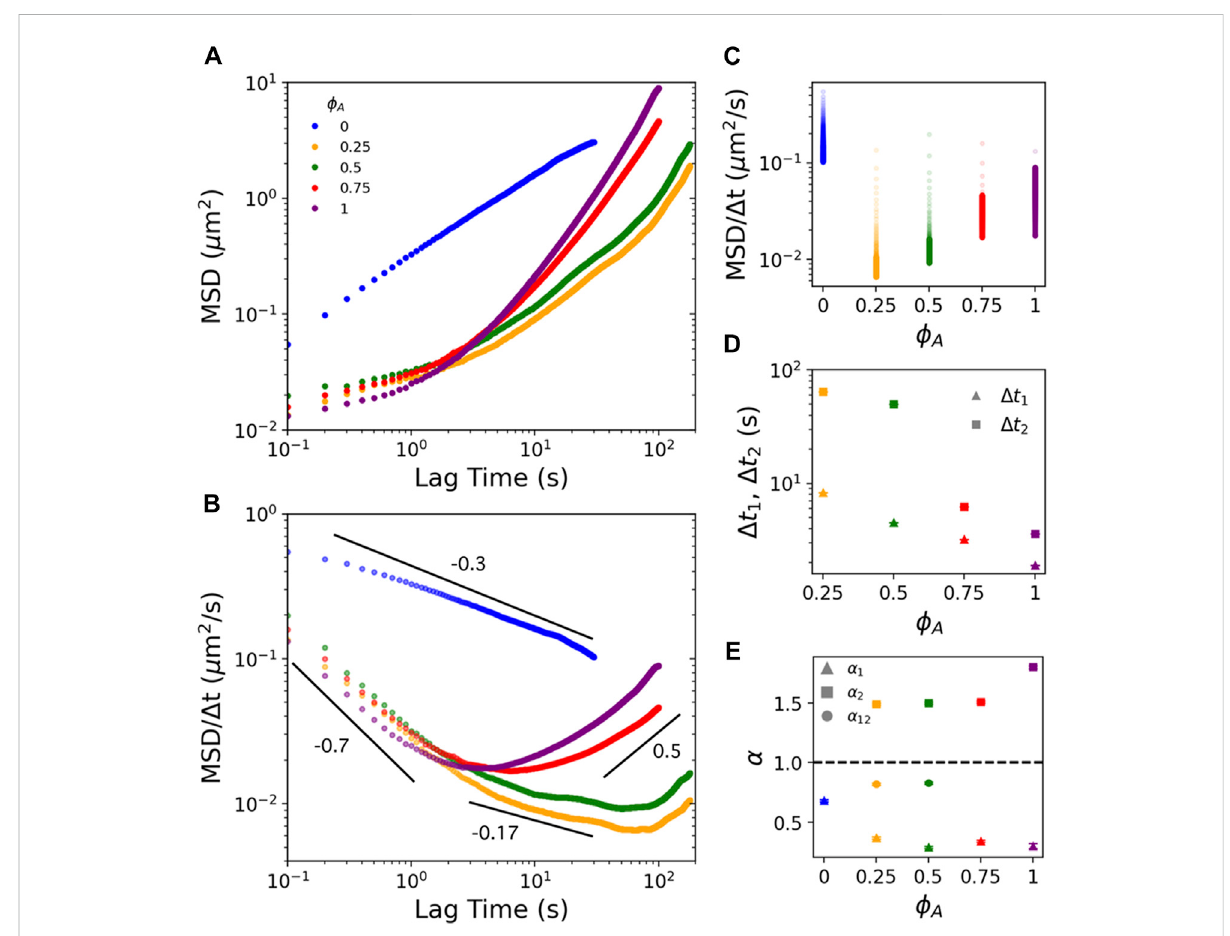
FIGURE 2 Actomyosin activity in actin-microtubule composites endows multi-phasic particle transport marked by pronounced subdiffusion at short lag times and superdiffusion at long lag times. (A) Mean-squared displacements ( MSD ) plotted versus lag time Δ t for myosin-driven actin-microtubule compositeswithmolaractinfractionsof ϕ A (cid:2) 0(blue),0.25(gold),0.50(green),0.75(red),and1(purple).Fitsofthedatato MSD ~ Δ t α overdifferent Δ t ranges(shownin(B))determinetheanomalousscalingexponents α i thatdescribethedynamics(seeFigure1). (B) Mean-squareddisplacements scaled by lag time ( MSD / Δ t ) plotted versus lag time Δ t delineate regions of subdiffusion (negative slopes) and superdiffusion (positive slopes). Color coding is according to thelegend in (A) .Black linesindicate fi tsto MSD ~ Δ t α over theshort ( Δ t < Δ t 1 ) , long ( Δ t > Δ t 2 ) and intermediate ( Δ t 1 < Δ t < Δ t 2 ) time regimes where each curve is well- fi t by a single power law. (C) Data shown in B plotted versus actin fraction ϕ A , with all MSD / Δ t values for each ϕ Δ t from light to dark. The magnitude of each data point isproportional to a A plotted along thesame vertical, with thegradient indicating increasing transport rate, with higher values indicating faster motion. (D) Lag time at which each composite transitions out of initial subdiffusive transport ( Δ t 1 ) and transitions into superdiffusivity ( Δ t 2 ). (E) Anomalous scaling exponents α i derived from fi ts shown in (B) for Δ t < Δ t 1 ( i (cid:2) 1), Δ t > Δ t 2 ( i (cid:2) 2), and ( Δ